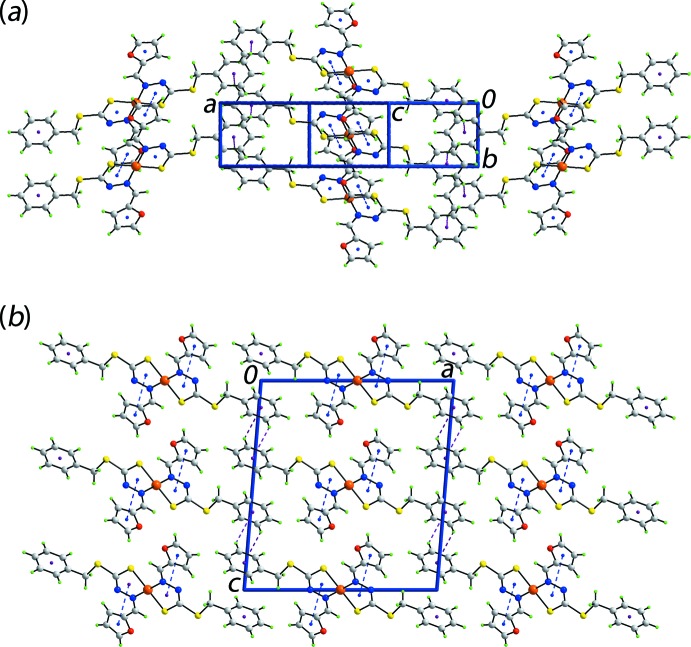
Mol­ecular packing in (I): (a) a view of the supra­molecular layer sustained by π(chelate ring)–π(fur­yl) and phenyl-C—H⋯π(phen­yl) inter­actions shown as blue and purple dashed lines, respectively, and (b) a view of the unit-cell contents shown in projection down the b axis highlighting the stacking of layers.